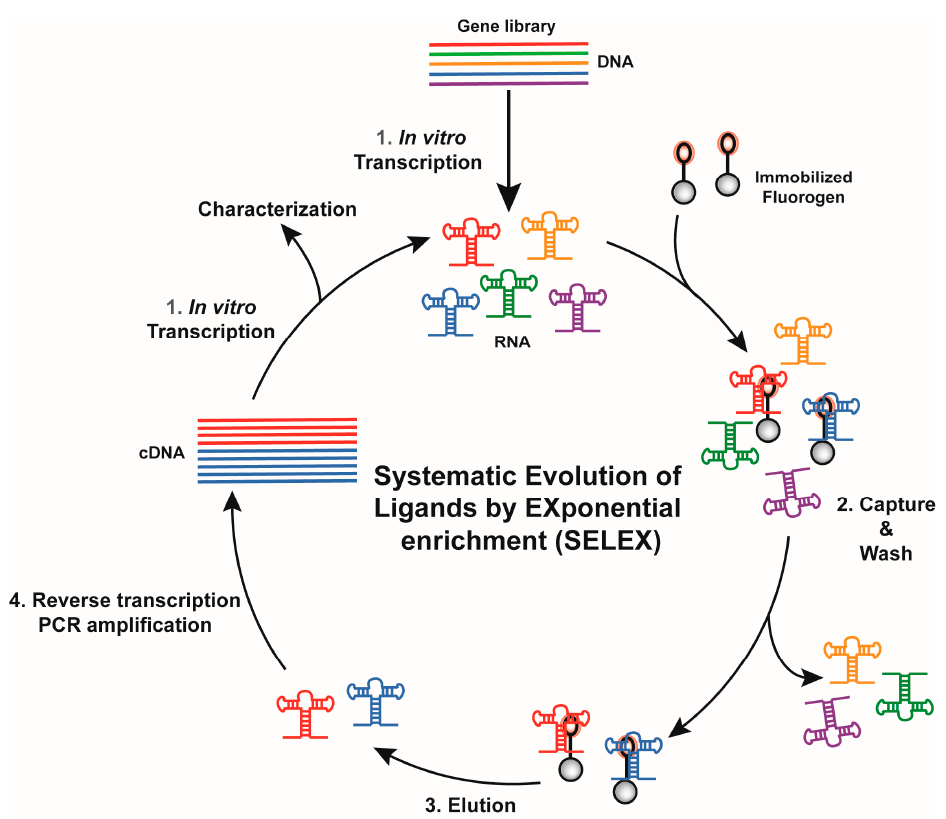
Figure 2. General overview of an in vitro selection using Systematic Evolution of Ligands by EXponential enrichment (SELEX). Each round proceeds in four main steps. A gene library is in vitro transcribed (Step 1) and mixed with beads displaying the fluorogen. Poor binders are eliminated by wash of variable stringency (selection pressure, Step 2) prior to recovering binding RNAs during the elution step (Step 3). Finally, RNAs are converted into cDNAs (Step 4), later used to prime a new round of selection.